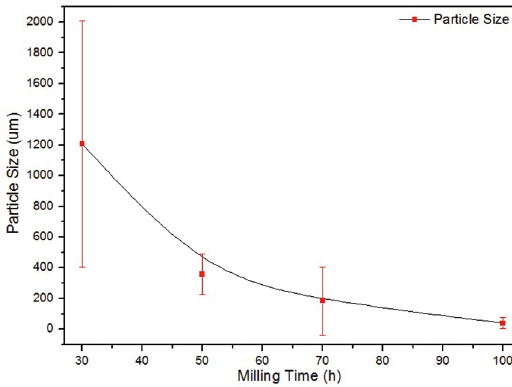
Figure 9. Particle size analysis in function of milling